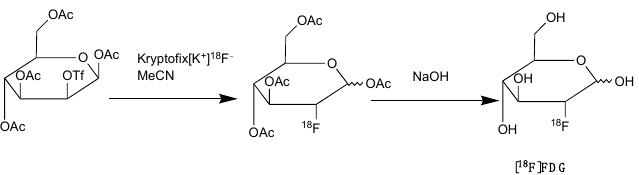
Figure 2. Synthesis of [ 18 F]FDG with nucleophilic fluorination followed by strong base deprotection. Targeting of cell-surface markers by PET tracers provides increased specificity for subsets of tumour-infiltrating cells and may allow early determination of treatment